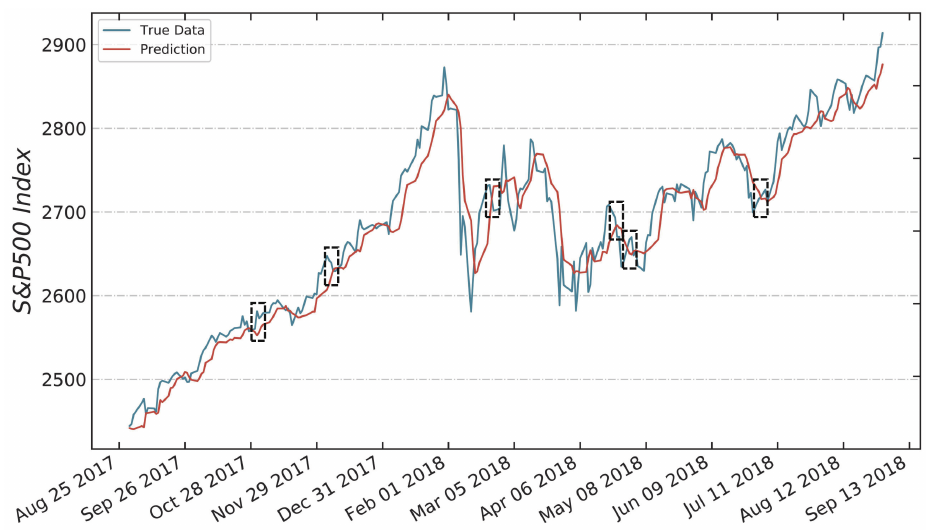
Figure 1. An example of the lagging phenomenon: prediction results for the S&P500 index from August 2017 to September 2018 using a long short-term neural